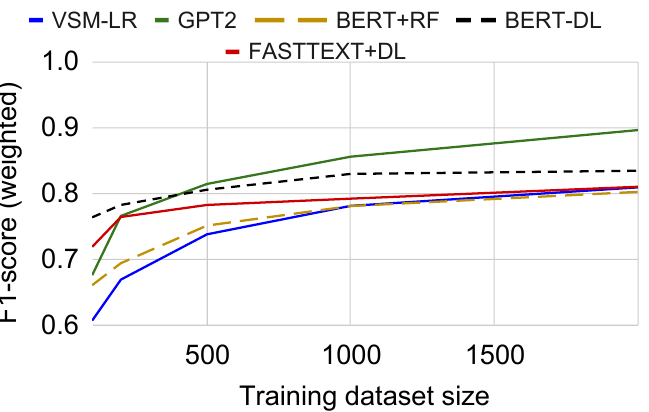
Figure 8. Classification performance (weighted F1-score) for the different combinations of language model and classifiers (few training